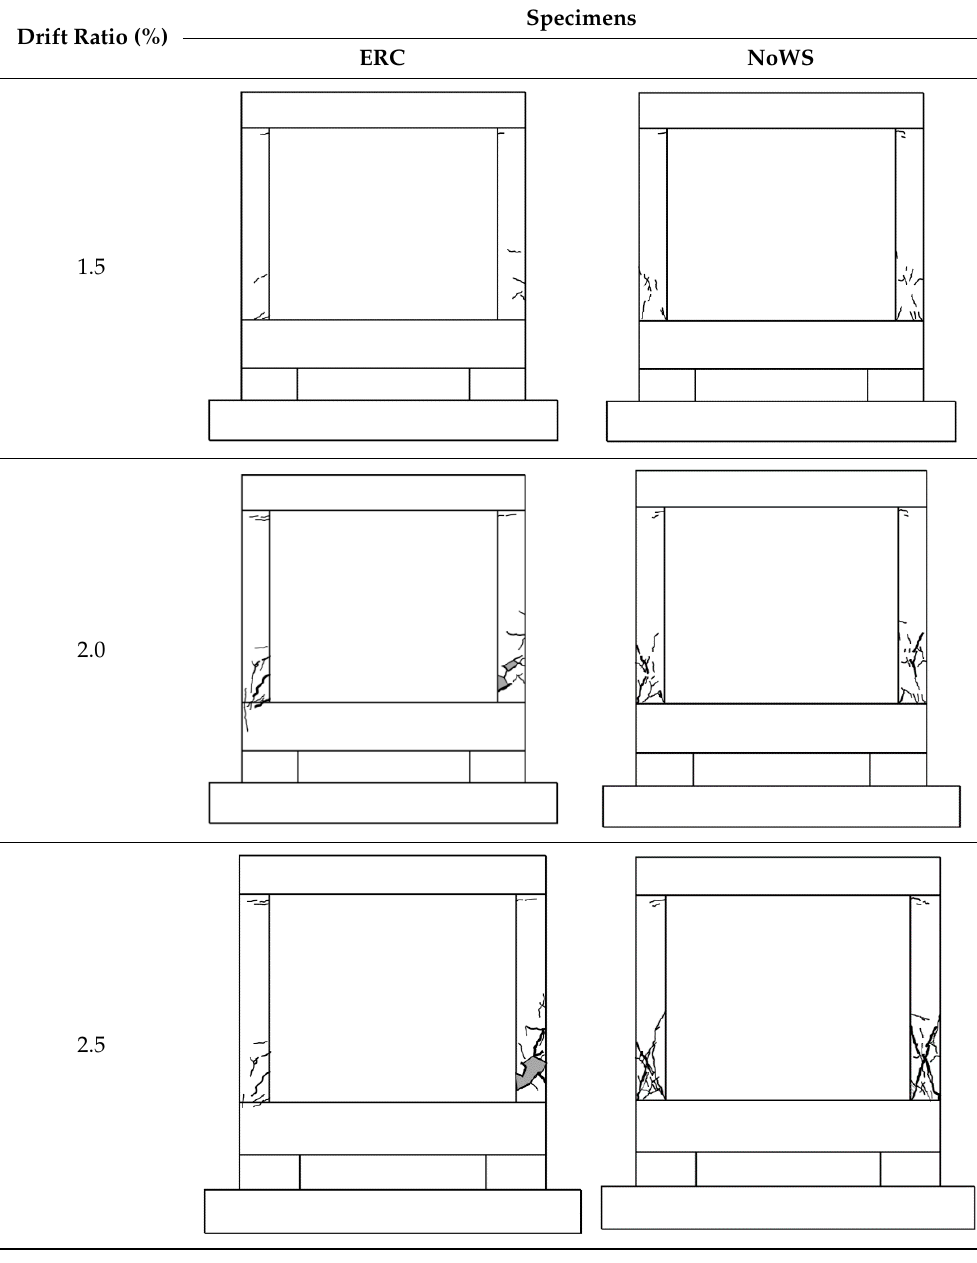
Table 3. Crack propagation.